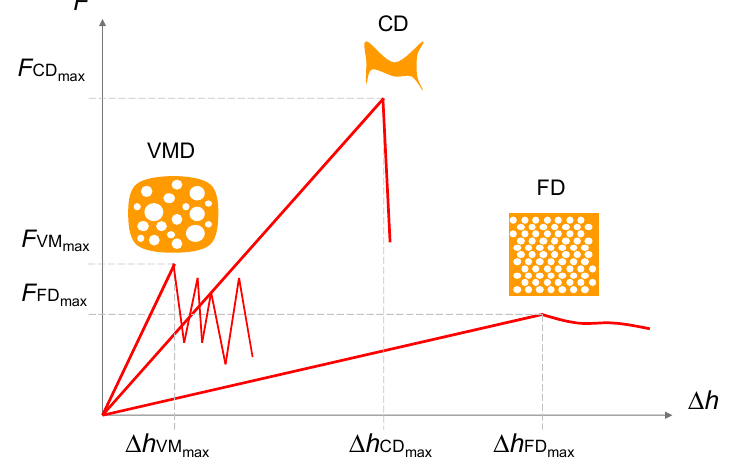
Figure 4. Typical force–deformation relationship F = f( Δ h ) in compression test for products dehydrated by freeze drying (FD), vacuum-microwave drying (VMD) and convective drying (CD).